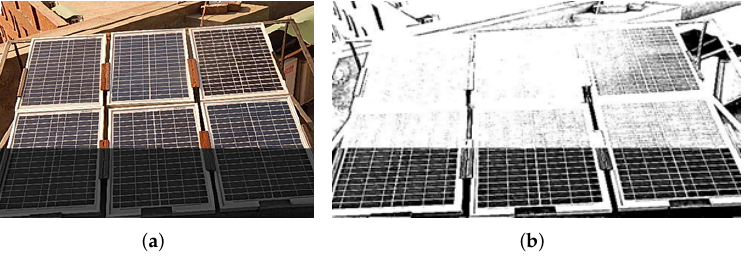
Figure 7. Image processing. ( a ) Partial shading case 1, hardware verification. ( b ) Processed